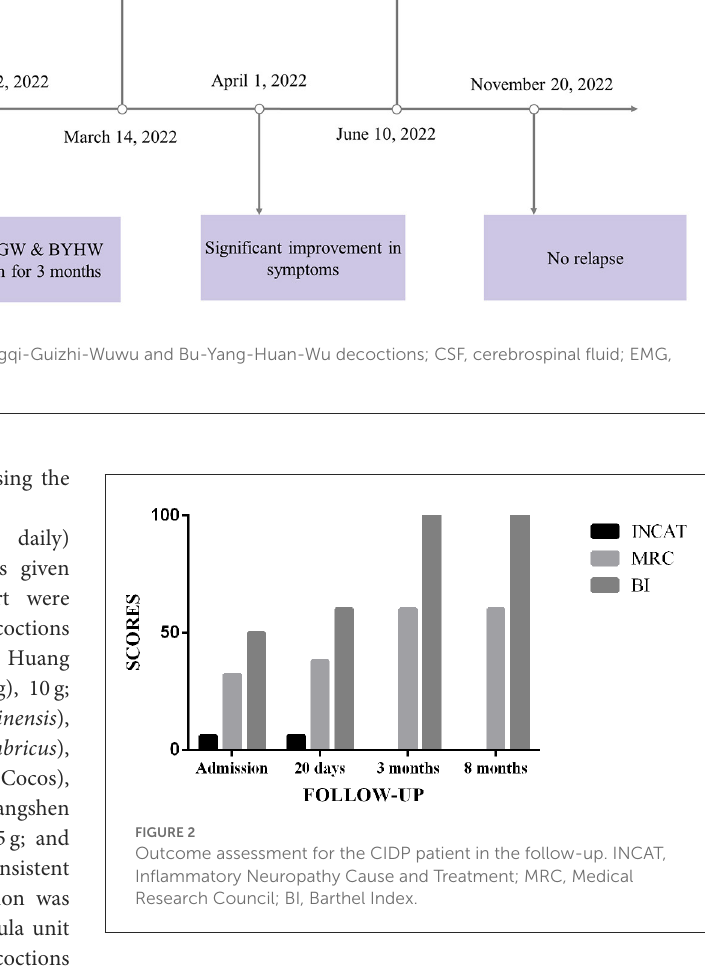
FIGURE2 Outcome assessment for the CIDP patient in the follow-up. INCAT, Inflammatory Neuropathy Cause and Treatment; MRC, Medical Research Council; BI, Barthel